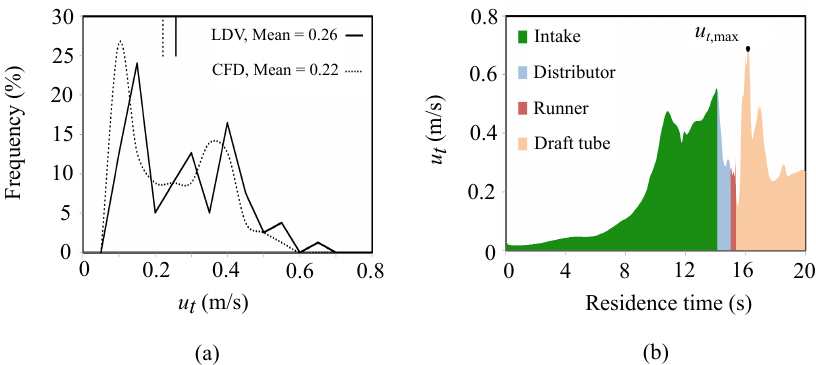
Figure A2. Comparison of ( a ) u t from LDV and CFD in upstream model and ( b ) the time series of u t that fish could potentially encounter, calculated using one thousand